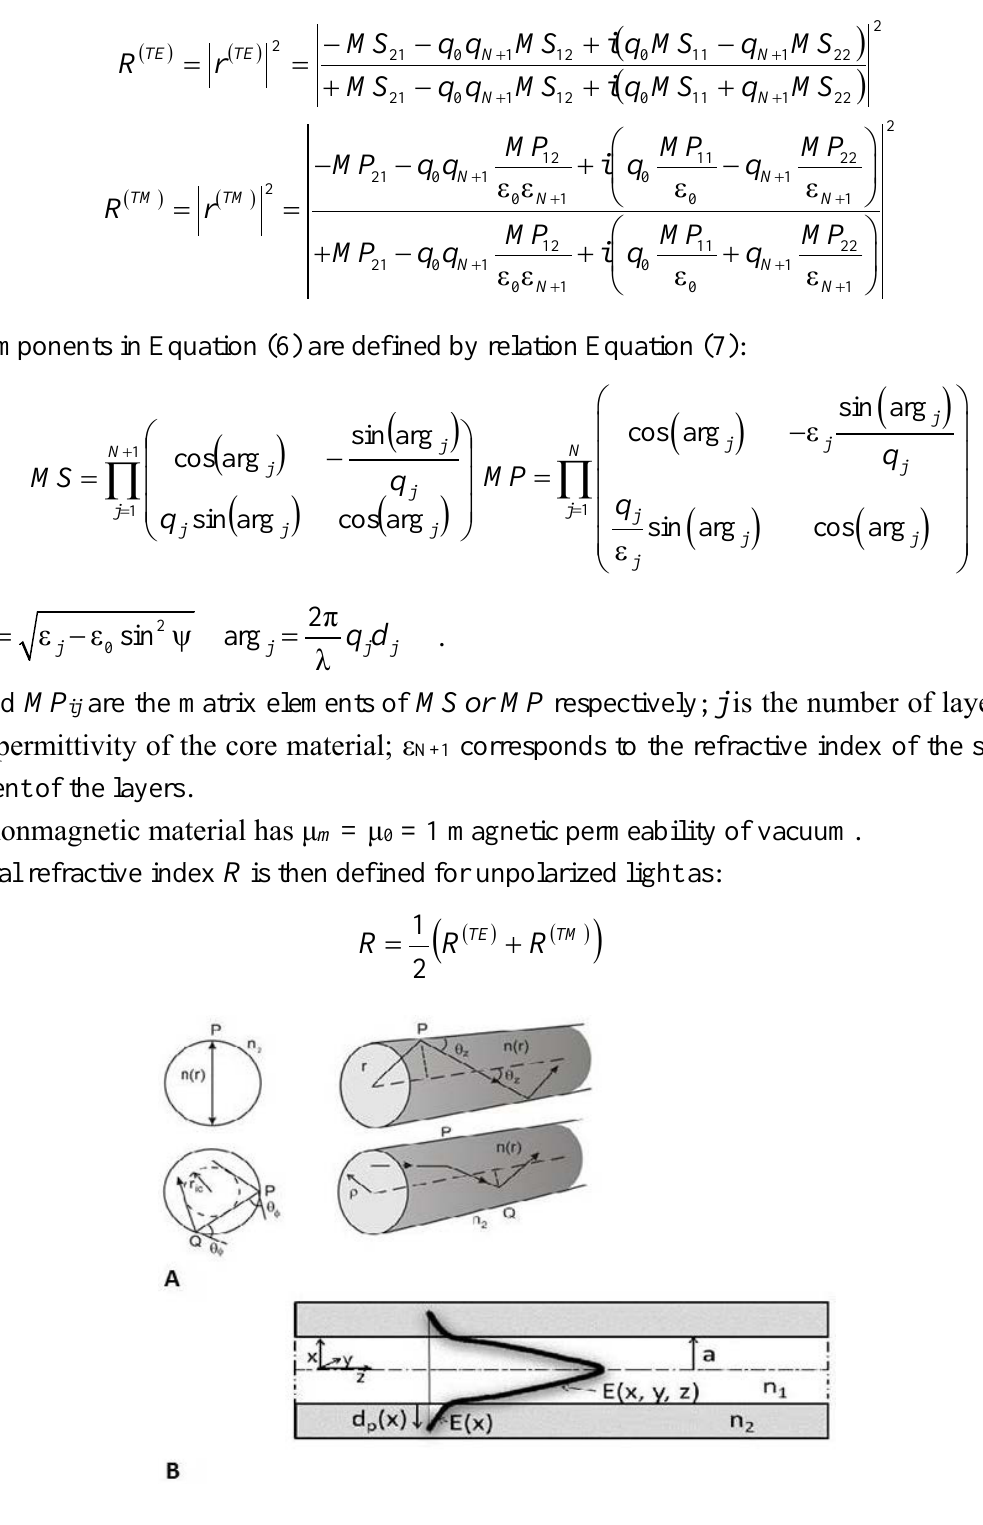
Figure 3. ( A ) Scheme of rays (meridian rays cross the fiber axis and scew rays do not cross the fiber axis) in the core of the optical fiber in the approach of geometric optics; ( B ) Scheme of Evanescence field E ( x ) and penetration depth d p ( x ). Reproduce from [47] with the permission of the CTU